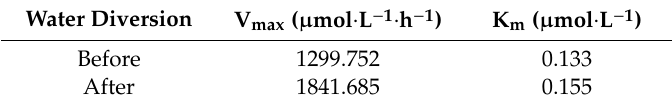
Table 1. Kinetic parameters of alkaline phosphatase before and after water diversion.